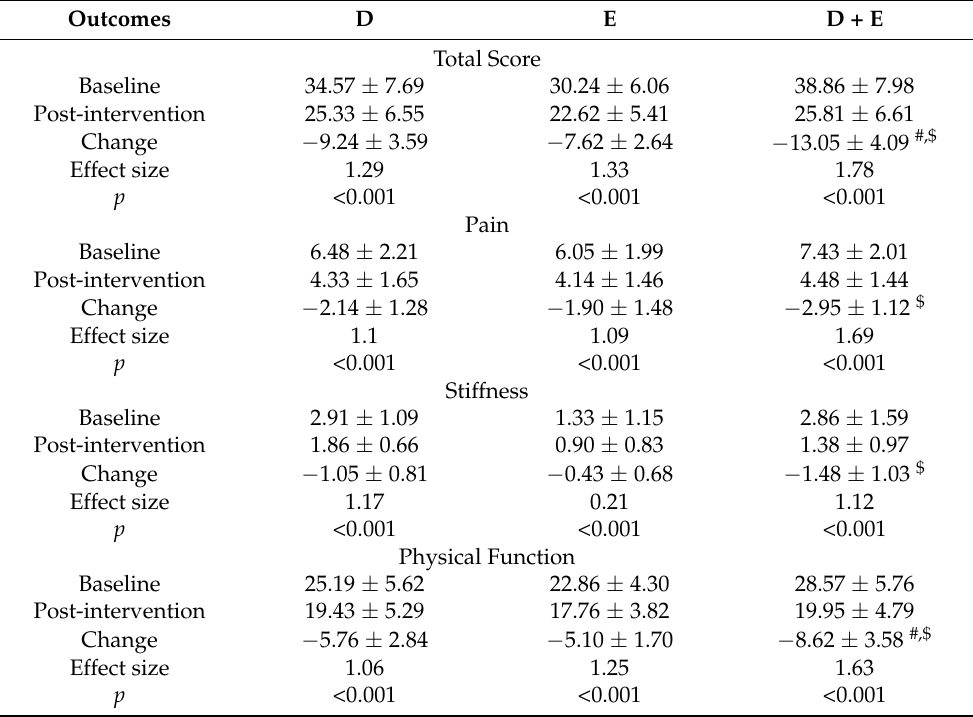
Table 3. Improvements in WOMAC scale after the 12-week